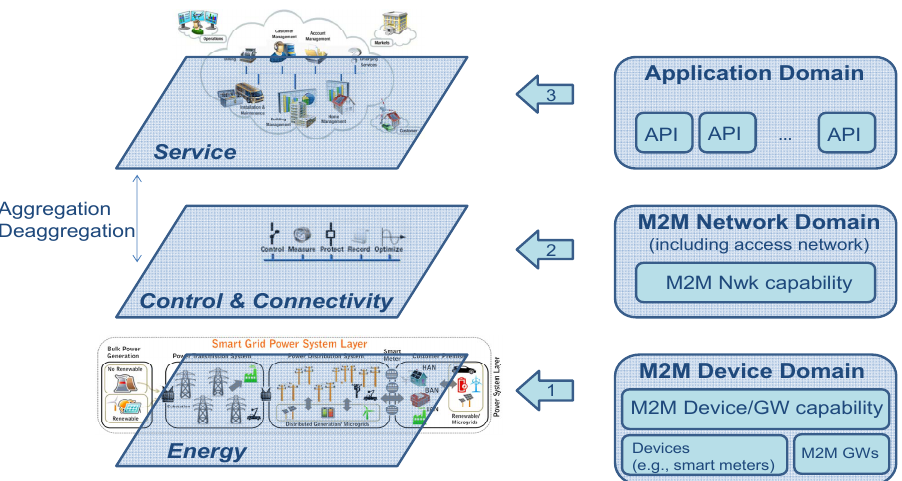
Figure 6. Mapping of ETSI M2M main domains onto the Smart Grid main layers